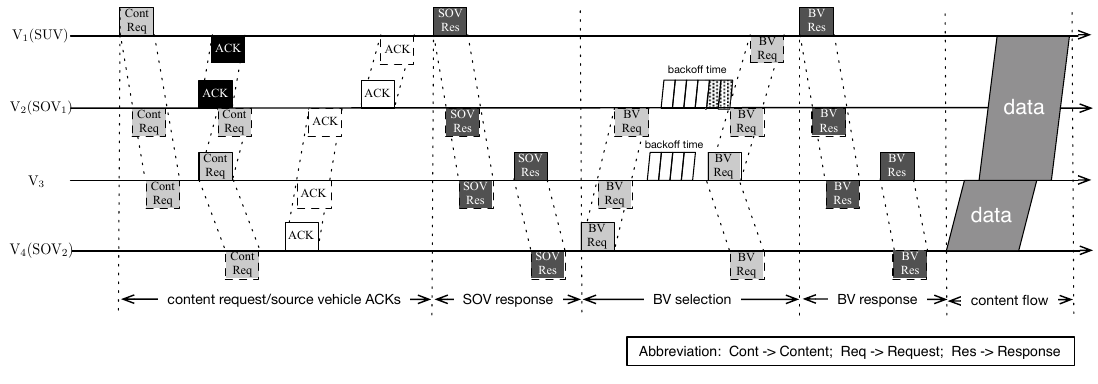
Figure 3. The flowchart for the designed routing